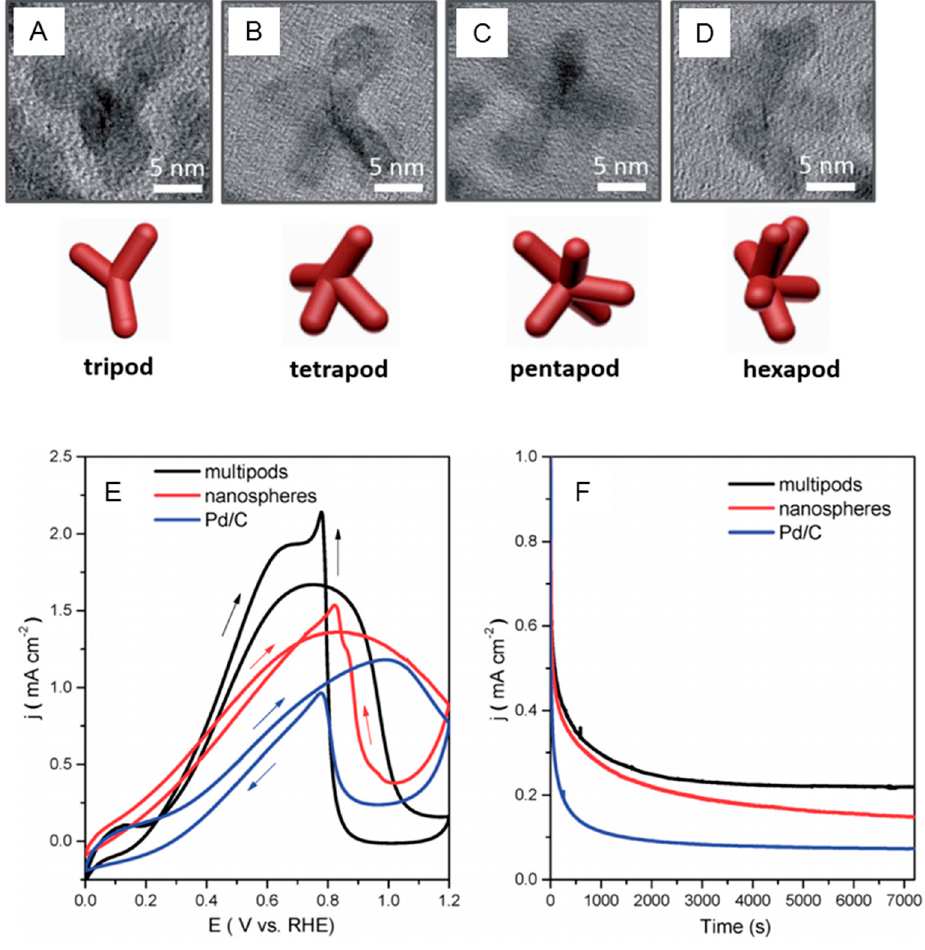
Figure 3. High-resolution (HR)-TEM images ( A – D ) of Pd–Cu multipods with different pod numbers and the corresponding three-dimensional models. ( E ) Cyclic voltammograms and ( F ) chronoamperograms of Pd–Cu multipods, Pd–Cu nanoparticles and the Pd/C catalyst at 0.4 V in 0.1 M HClO 4 and 1 M formic acid. Reproduced with permission [50]. Copyright 2016, Royal Chemical Society.